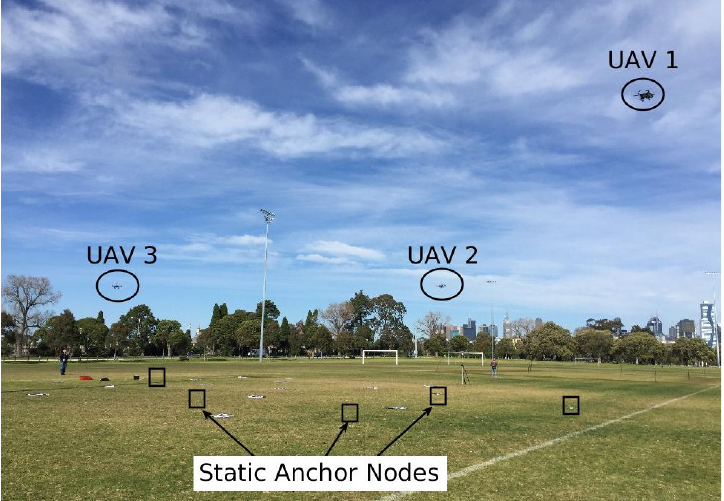
Figure 6. Experimental setup for cooperative localization. Three of the four UAVs can be seen in this image.